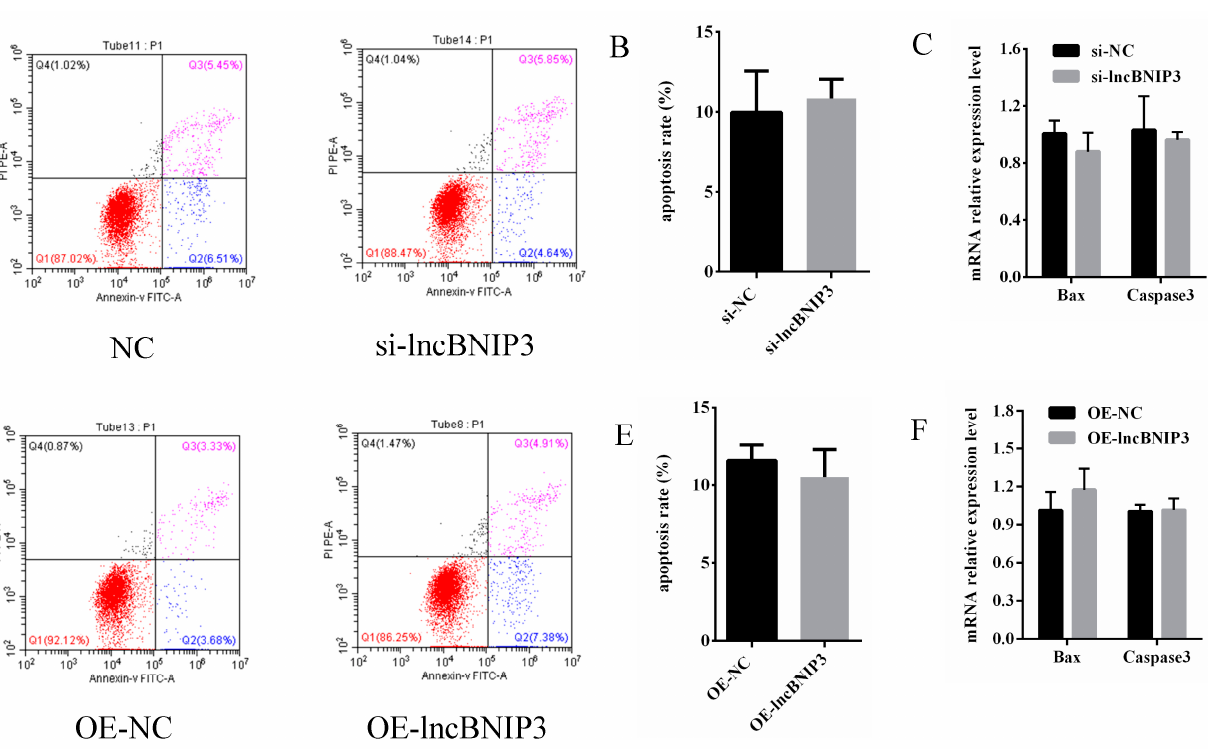
Figure 7. LncBNIP3 had no significant effect on the apoptosis of bovine intramuscular preadipocytes. ( A ) Flow cytometry results after transfecting si-lncBNIP3 and si-NC for 48 h; ( B ) Statistical data of the flow cytometry results; ( C ) Expression levels of Bax and Caspase3 mRNA after transfecting si-lncBNIP3 and si-NC for 48 h; ( D ) Flow cytometry results after transfecting OE-lncBNIP3 and OE-NC for 48 h; ( E ) Statistical data of the flow cytometry results; ( F ) Expression levels of Bax and Caspase3 mRNA after transfecting OE-lncBNIP3 and OE-NC for 48 h.